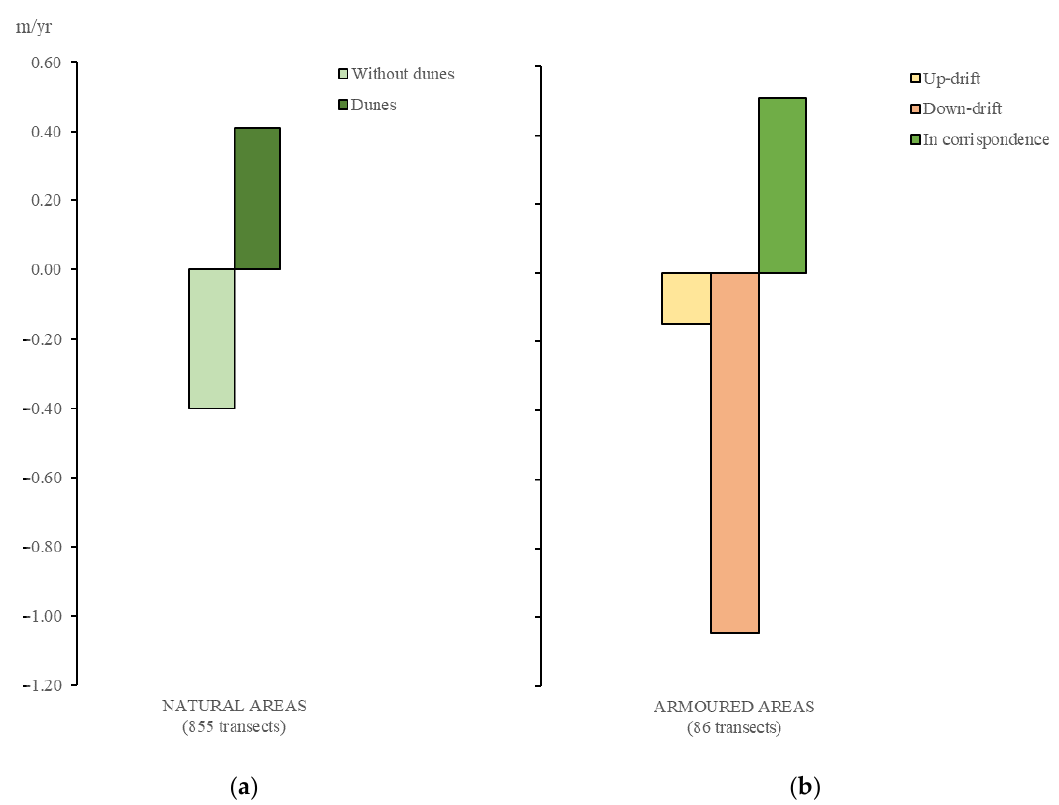
Figure 11. Shoreline evolution plot of the average WLR values found in correspondence of transects placed at ( a ) natural areas, subdivided into areas backed by dunes (93 transects) and areas without dunes (762 transects), and at ( b ) armoured areas, considering the up-drift and down-drift zones and in correspondence of structures (48 transects).